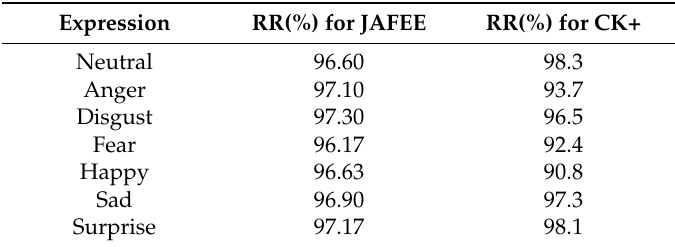
Table 6. Results without the application of CLAHE. RR—recognition rate.